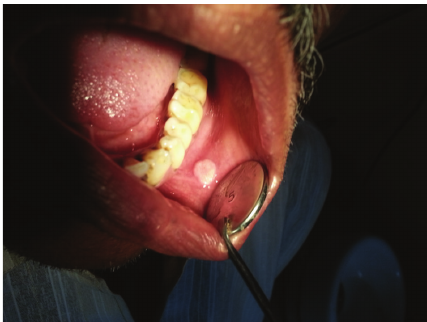
Figure3:Presenceoflargenumbersoflipid-ladenfoamyhistiocytes confined to the connective tissue papillae (H&E stain 40x).